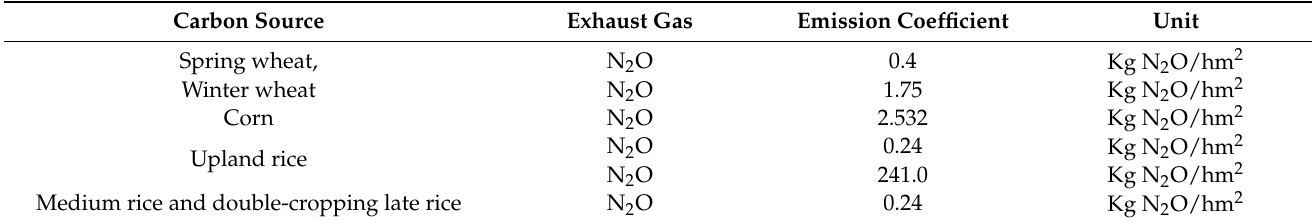
Table 2. The gas emission types and corresponding emission factors according to food